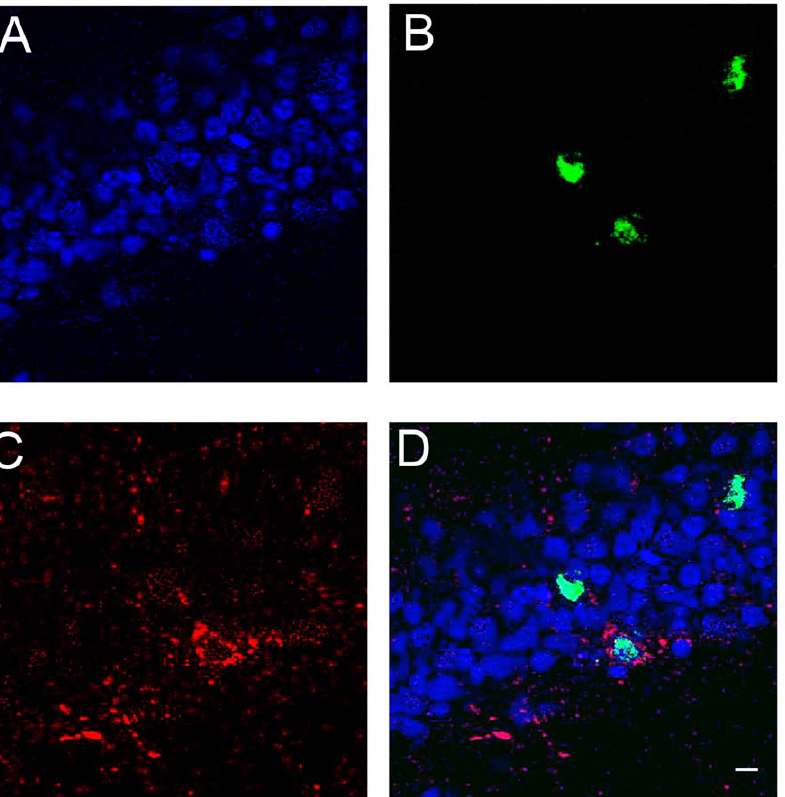
Figure 4. Arc expression in DCX-positive cells. The images show double immunohistochemistry for Arc and DCX, and were taken with the Apotome microscope system (Zeiss) with a 40 6 /1.3 NA objective using Z section resolution. A) DAPI is shown in blue, B) Arc protein is shown in green, C) DCX is shown in red, and D) the 3 channels were merged. Scale bar=100 m m.